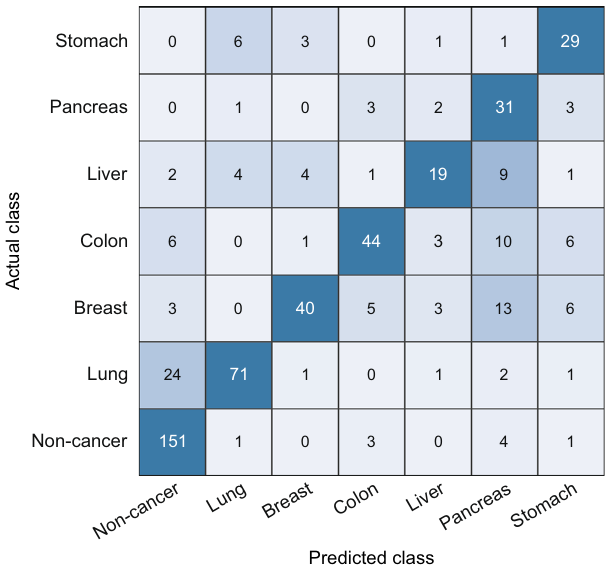
Fig. 5 | Confusion matrix for the entire test sample. Prediction results for 520 untrained test samples through the fi nal decision model combining cancer pre- sence detection and TOO discrimination. Cancer presence was determined by whether the mean score was greater than the cutoff value. TOO was determined based on a multiclassi fi cation result built through a multi-layer perceptron